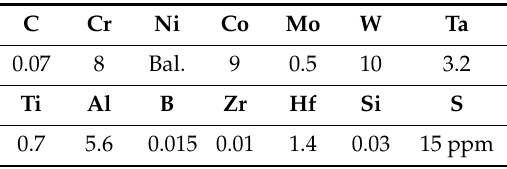
Table 1. Chemical composition of CM247LC